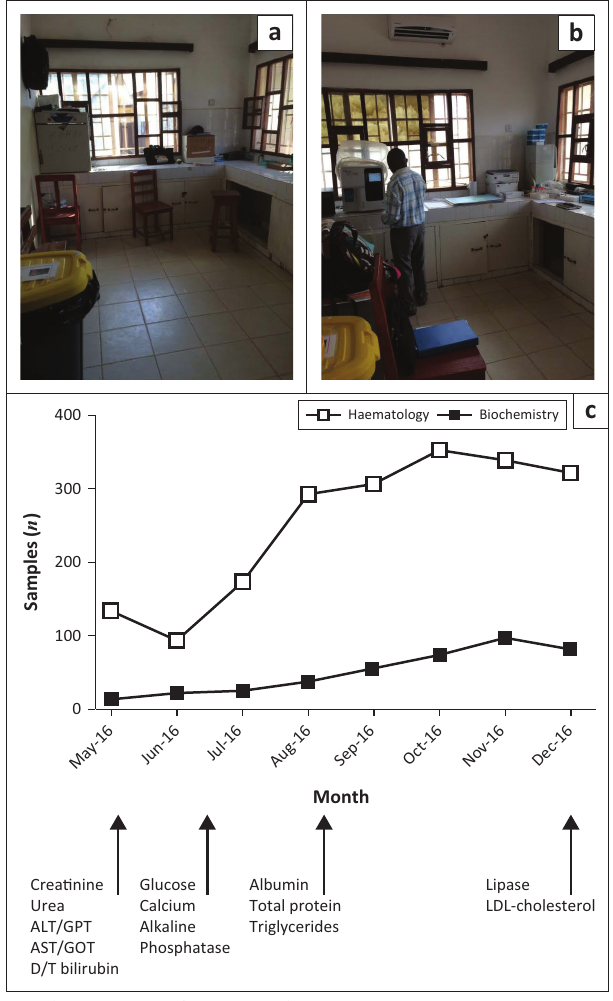
FIG URE 2: Introduction of haematology and biochemistry services, Koidu Government Hospital central laboratory, Sierra Leone, 2016. (a) The haematology laboratory before introduction of equipment, with a broken incubator for storage (left) and (b) after installation of air conditioning and equipment, with a technician turning on the haematology machine (right). (c) Number of haematology (closed squares) and biochemistry (open squares) samples received for testing during the first six months of introducing the new equipment. Below the x-axis is indicated when various biochemistry tests were